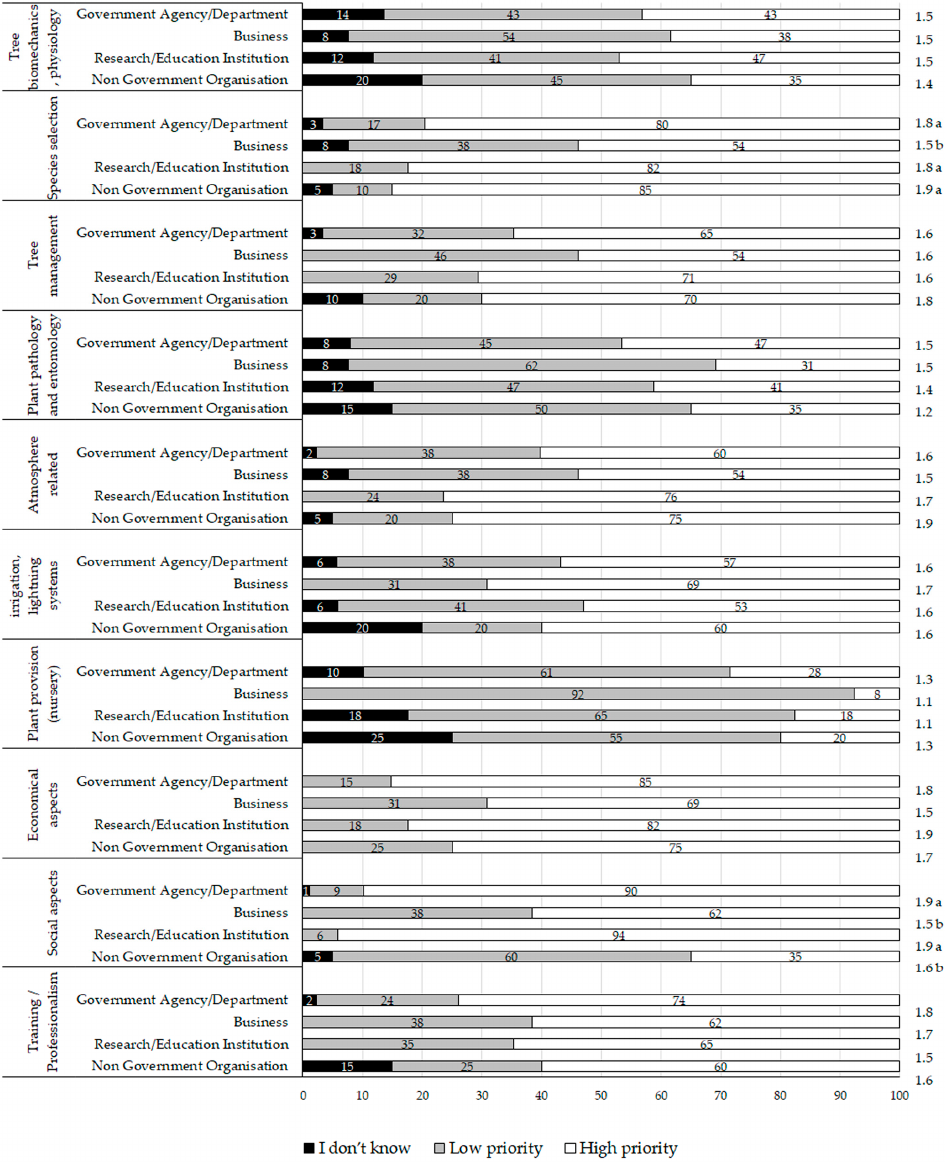
Figure 4. Level of priority given by respondents from different categories to different fields of investigation related to urban green areas. Percentages of responses in each level of priority are reported. Statistical differences between percentages have been identified by the Fisher exact test. Mean values of the level of priority have been calculated by assigning 2 to high priority, 1 to low priority, and 0 to I don’t know. Mean values are shown on the right side of the bars. Statistical differences between mean values of different categories (indicated by small letters next to the mean values) have been identified by the ANOVA test, followed by the LSD test at p < 0.05 ( n = 137).